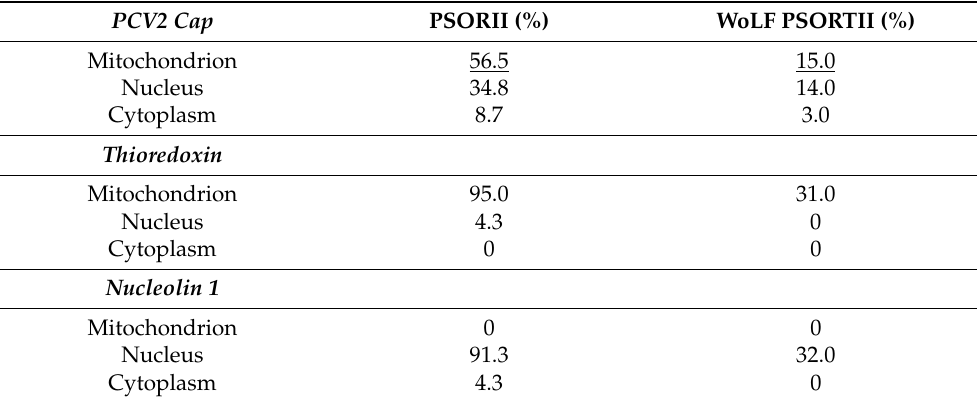
Table 1. Prediction of the subcellular localization of proteins.